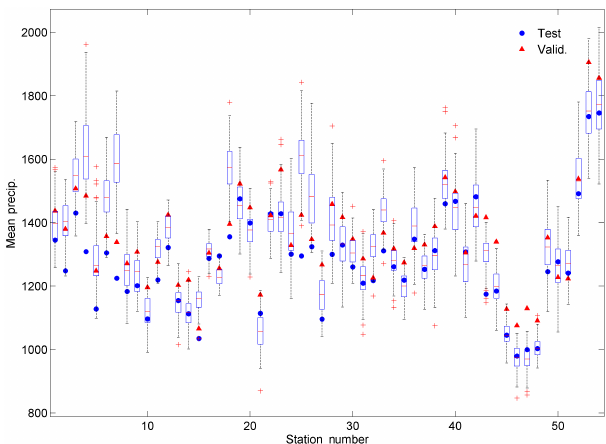
Figure 4. Annual mean precipitation (mm) of the IBB simulation (box plot) and the observation over the validation period (filled blue circle) as well as the test period (filled red triangle) conditioned with the temperature change (see Fig. 3). Note that the observed mean precipitation over the validation period (1994–2008) (see the red triangles) shows mostly higher than the mean over the test period (1976–1993) (see the blue circles). Also, the IBB-simulated pre- cipitation (box plot) reflects this tendency showing higher than the mean precipitation of the test period (blue circles). Boxes indicate the interquartile range (IQR), and whiskers extend to ± 1.5IQR. The horizontal lines inside the boxes depict the median of the data. Data beyond the fences ( ± 1.5IQR) are indicated by a plus symbol ( + ) , which represent